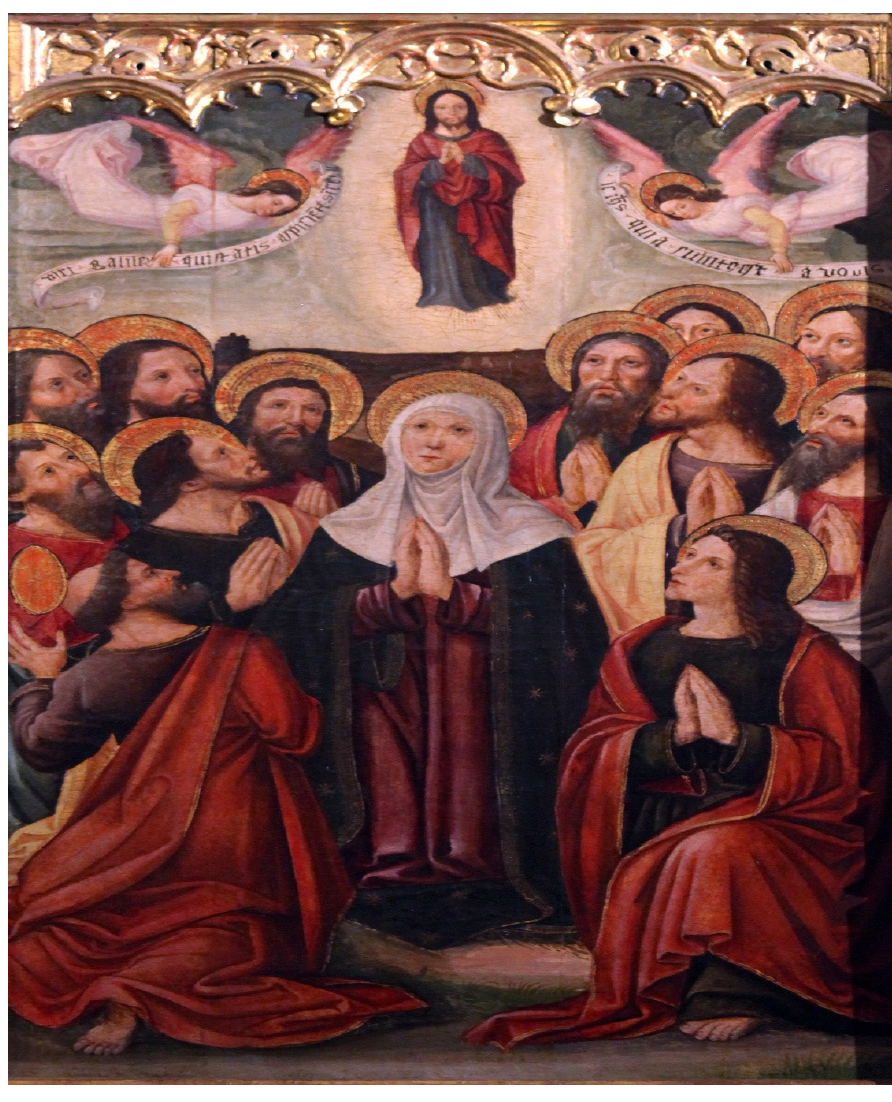
Figure 3. The Ascension of Jesus.